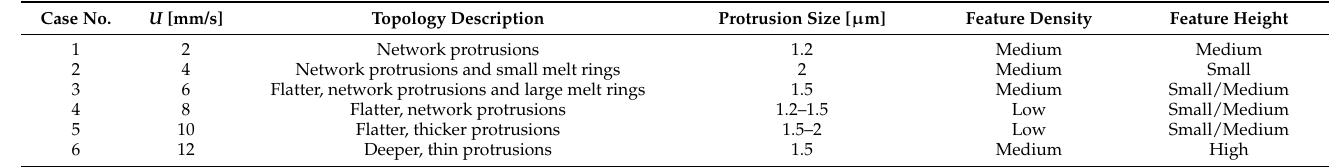
Figure 9. SEM images (2000× magnification) of the laser-interference-processed area using the laser raster method with a 5 mm spot size on copper. Each frame shows a different raster speed (mm/s): Table 4. Topology variation for the raster laser processing with 5 mm spot size.